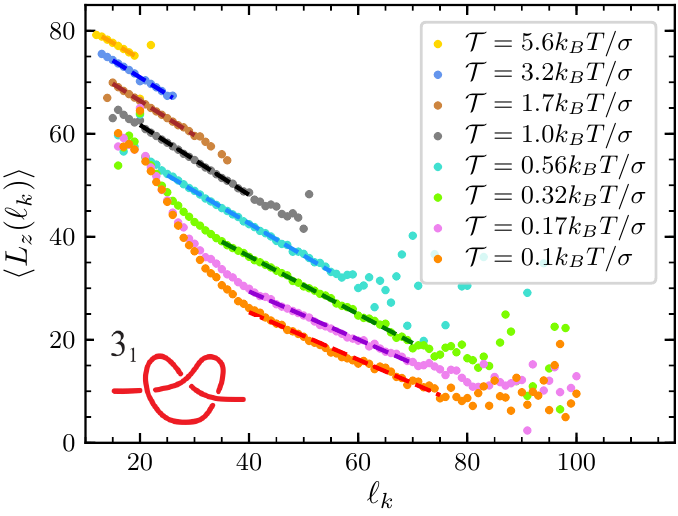
Figure A1. Average component of the end-to-end polymer extension along the direction of the pulling force as a function of the knot size, for the 3 1 knot. Various value of are considered. Dots are data T from molecular dynamics (MD) simulations starting with a trefoil knot tied in the middle of a chain of N = 100 beads. Dashed lines are fit to Equation (11) in the ranges of (cid:96) k spanned by the dashed lines themselves. Fits return b k 0.6 about independently of the pulling force and knot (cid:39)